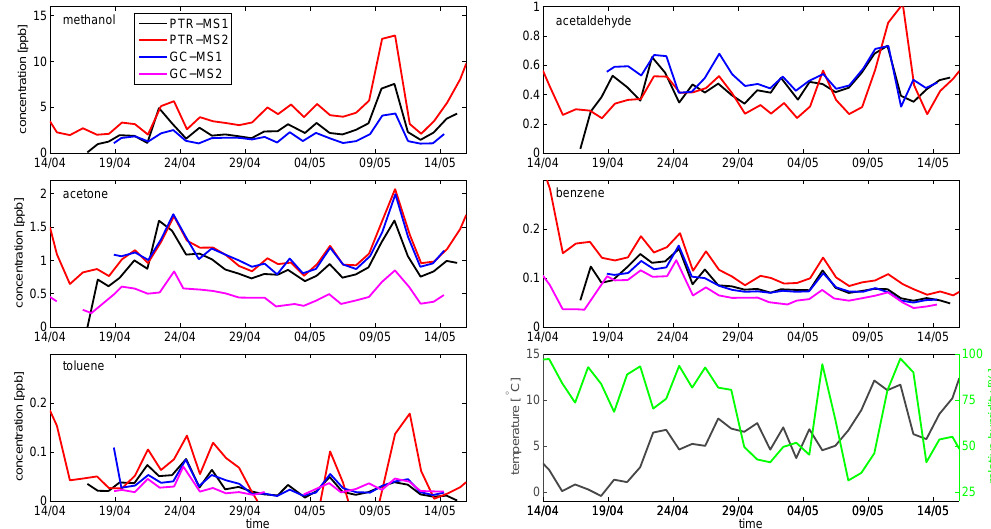
Figure 3. Daily median temperature, relative humidity and concentrations of compounds measured with PTR-MS1, PTR-MS2, GC-MS1 and GC-MS2 during the measurement